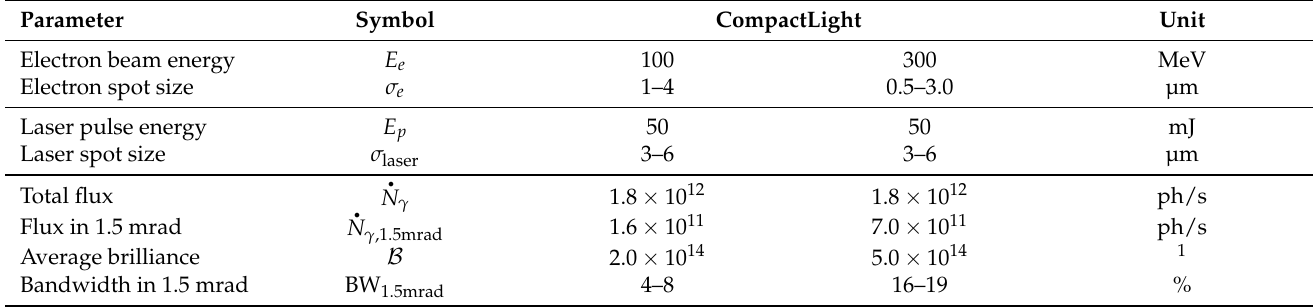
Table 5. Summary of parameters required to maximise the flux in a 1.5mrad cone of the XLS-based ICS source. The corresponding scattered photon beam parameters are also included.